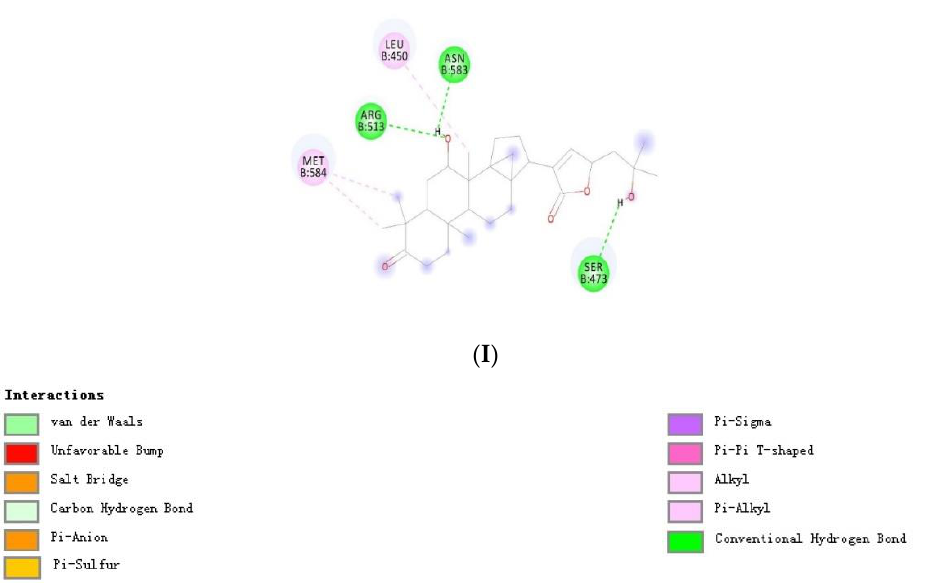
Figure 3. Hydrogen bonding patterns of potential Mortalin (PDB ID: 3N8E) inhibition compounds. ( A ) Compound 21; ( B ) Compound 22; ( C ) Compound 19; ( D ) Compound 34; ( E ) Compound 38; ( F ) Compound 16; ( G ) Compound 17; ( H ) Compound 14; ( I ) Compound 18.